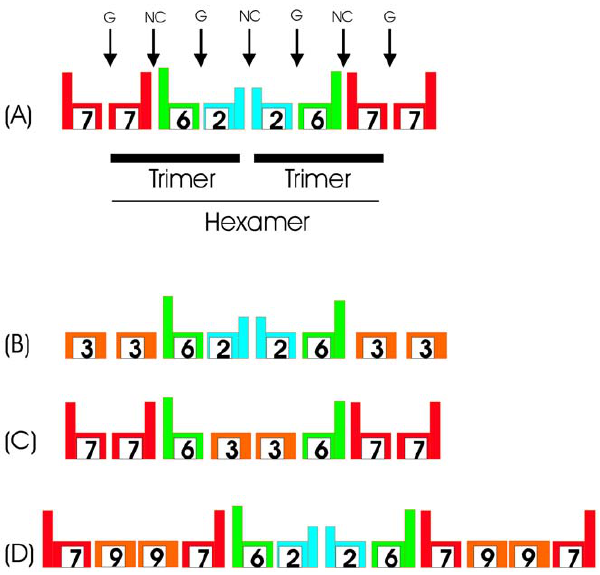
Figure 4. Schematic representation of possible septin-septin interactions within putative filaments, based on a combination of our yeast two hybrid assay’s data and previously published data. (A) the canonical or standard filament taken from the crystal structure of the 7-6-2 complex [18] showing the trimeric and hexameric cores and the NC and G interface. The 7-6 dimer is believed to be stabilized by a long coiled coil at an NC interface, whilst the 2-2 dimer is similarly stabilized by a short coiled coil. (B) possible arrangement for a filament composed of members from the SEPT3, SEPT6 and SEPT2 groups. SEPT3 group contains both septin 3 and 9. This arrangement would leave the SEPT6 coiled coil unpaired and ‘‘free’’ for interaction with other coiled-coil containing proteins (see text for details). (C) possible arrangement for a filament composed of members from the SEPT3, SEPT6 and SEPT7 groups. (D) possible position for SEPT9 compatible with the observed yeast two-hybrid data and data from the literature [38] (see also Fig.